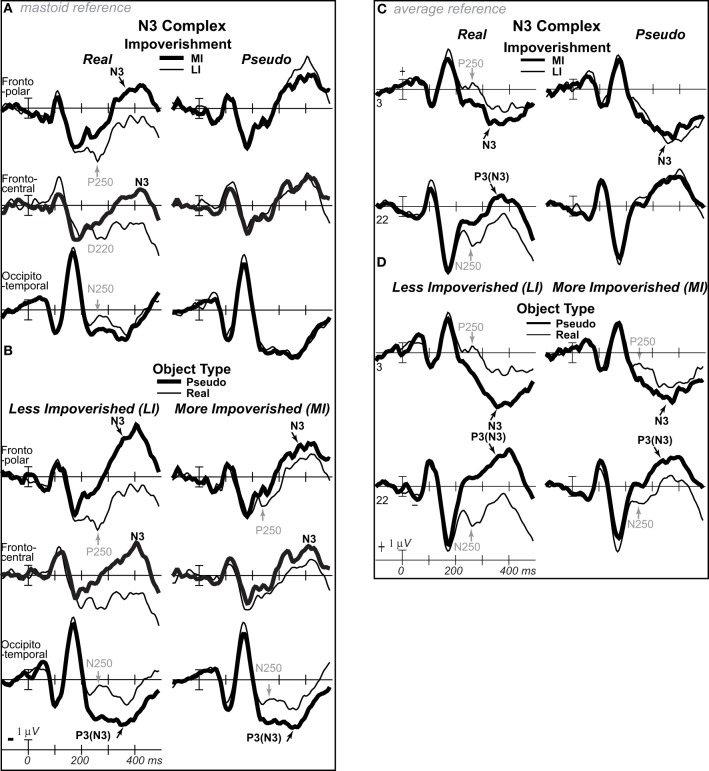
ERP effects of impoverishment and object type on the N3 complex. (A,B) Shown are sites of the N3 complex maxima (left frontopolar site 3, right frontocentral site 30, right occipitotemporal site 22). Frontal effects inverted polarity to positivity at occipitotemporal sites, especially on the right (“P3[N3]” maximal at site 22), including an N250; note, a D220 index of task difficulty for decisions also inverted polarity between frontocentral and occipitotemporal sites. (A) N3 effects of impoverishment shown for real objects and pseudo objects. The frontal N3 showed an impoverished-real-object effect, including a frontopolar P250 component: The frontal N3 components were more negative for MI than LI real objects but not pseudo objects; note, the N3 showed no such effect for pseudo objects, but, in contrast, briefly at the peak, the N3 was instead slightly more negative for LI than MI pseudo objects. The occipitotemporal N250 but not later posterior N3 counterparts showed impoverishments effects for real objects. (B) N3 effects of object type shown on LI and MI trials. The N3 complex was larger for real than pseudo objects, and this type effect was larger on LI than MI trials. (C,D) To compare with other publications, the reference was computed using the average of all scalp sites (i.e., “common average reference”), and ERPs were plotted positive up. Shown are left frontopolar site 3 and occipitotemporal site 22. (C) N3 effects of impoverishment shown, for real and pseudo objects. (D) N3 effects of object type shown on LI and MI trials. Here, with the average reference, the effects over occipitotemporal sites become larger than when the bilateral mastoid reference is used instead (see A,B): Notice the similarity of effects between frontopolar site 3 in (A,B) and occipitotemporal site 22 here [also site 22 in (A,B) is more like site 3 here]. Crucially, the frontopolar ERPs with a mastoid reference [e.g., P250, N3 in (A,B)] correspond, with the average reference shown here, to the occipitotemporal ERPs (e.g., N250, P3(N3) at site 22 here). This demonstrated a clear link between the present and prior research on the frontocentral N3 complex and its subcomponents, and prior research on the occipitotemporal N250 and Ncl, which were defined using the nose or average reference, as shown here; note scalp distribution shapes with nose and average reference are similar. Like the frontopolar P250/N3 with the mastoid reference (see A,B), here with an average reference, the occipitotemporal N250 and P3(N3) show the impoverished-real-object effect, being more positive for MI than LI real objects but not pseudo objects, and this effect inverts polarity over frontopolar sites to P250 and N3 effects. Further, like the frontopolar P250 and N3 with the mastoid reference (see A,B), here with an average reference, the occipitotemporal N250 and P3(N3) show object type effects, being more positive for pseudo than real objects on LI and MI trials, and these effects invert polarity over frontopolar sites. The whole head ERPs in Figure 4 demonstrate that this polarity inversion of effects occurs between frontal sites toward the midline (3–4, 11–12, 19–20, 29–30) and more lateral occipitotemporal sites with a right hemisphere maximum (22, 32, 34), especially for the N250, consistent with the known right lateralization of the N250 (i.e., N250r).